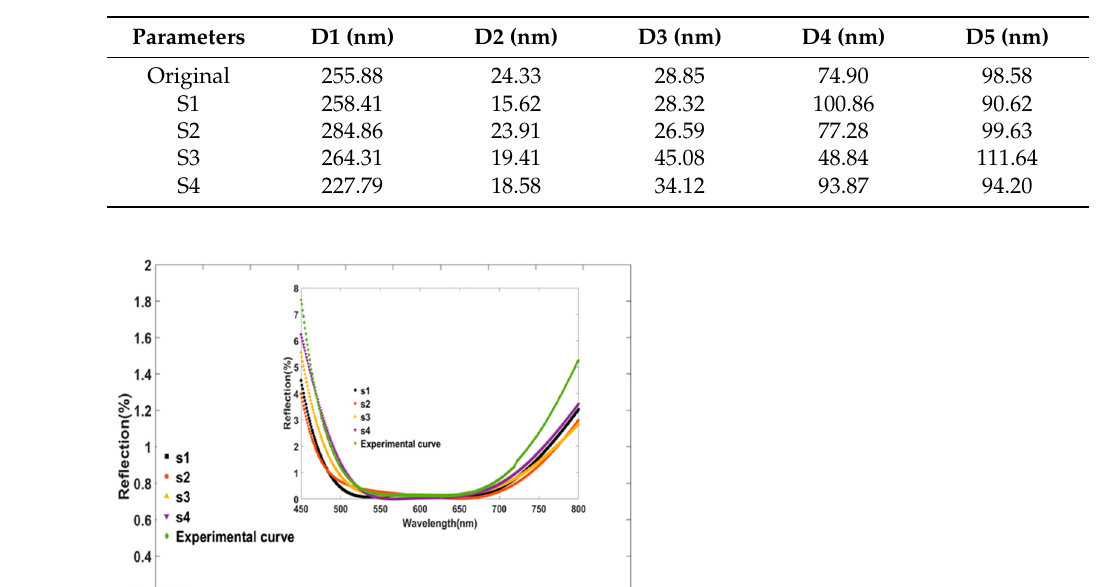
Figure 9. The results show that NN-PSO can obtain multiple designs for the same spec- trum, which can be used for parameter extraction and failure analysis applications. Table 3. The structures obtained by NN-PSO for the same spectrum in range of 550~650 nm.